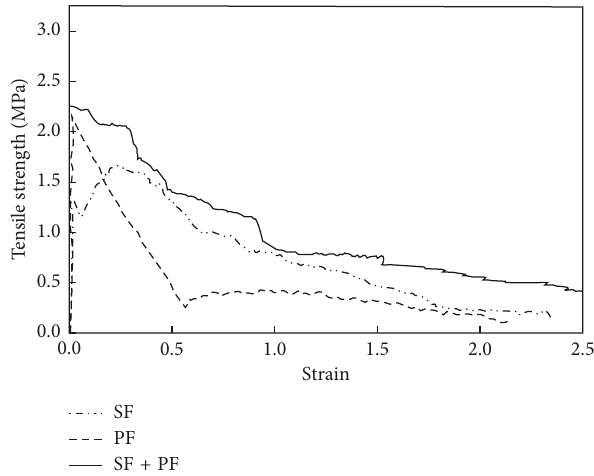
Figure 8: Influence of fiber combination on toughness of concrete mixture at 28-day